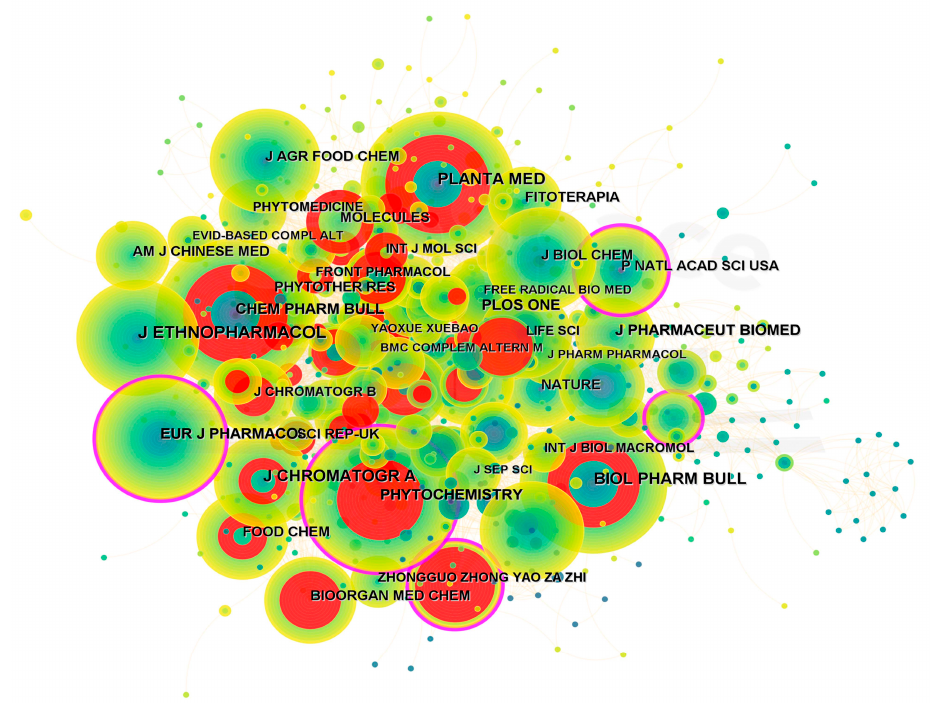
Figure 6. Co-cited journals in Cistanche -related study (1980–2022). Node size represents the number of citations. Purple circles indicate that the journal is a highlighted citation. Red nodes indicate journals have a citation burst over time.